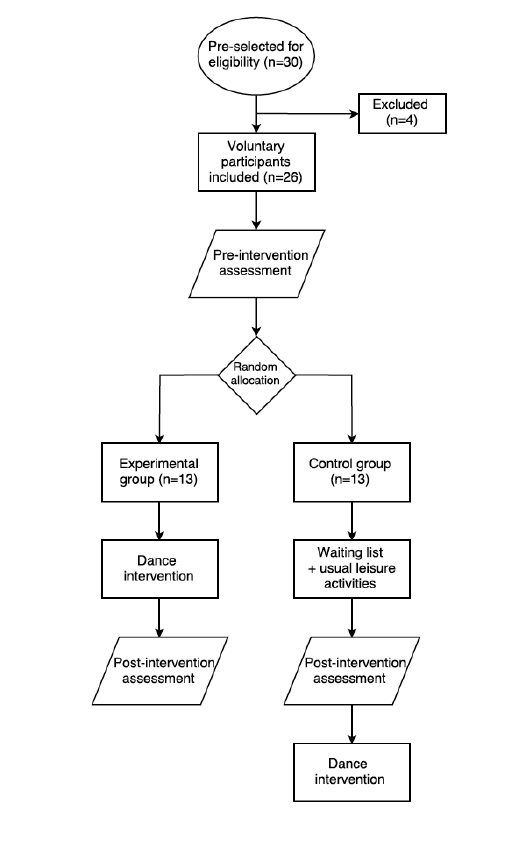
Fig. 2 Flowchart of the study design and